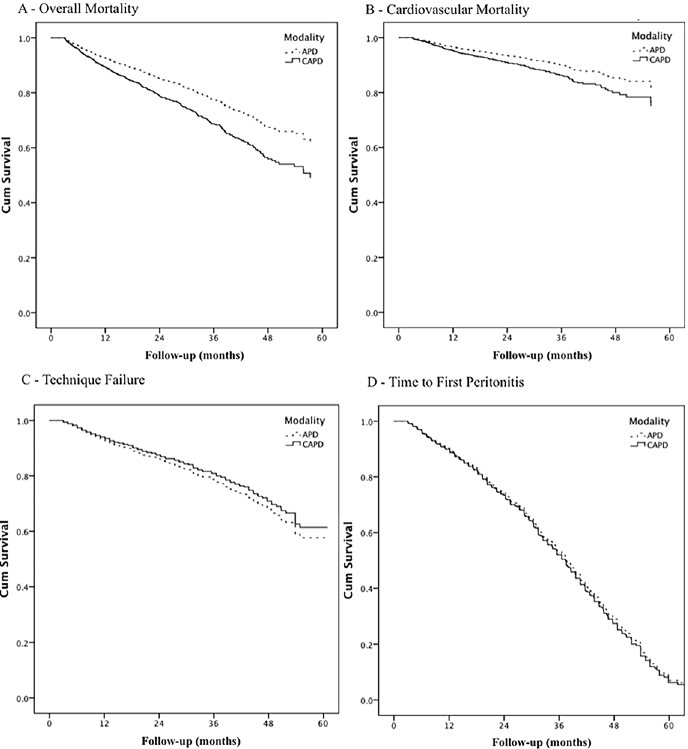
Fig 3. Clinical outcomes for Peritoneal Dialysis Modality. Legend: p values for overall mortality and cardiovascular mortality are < 0.01; for technique failure is 0.27 and for time to first peritonitis episode is 0.57.